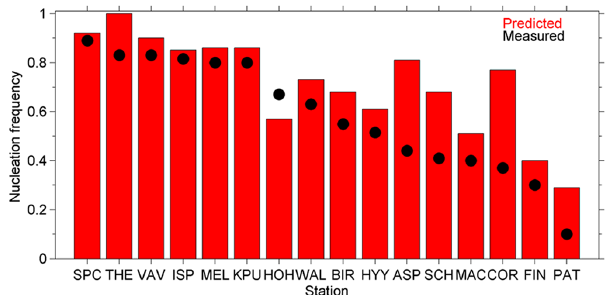
Figure 6. Predicted (red bars) vs. observed (black symbols) nucle- ation frequencies at the 16 measurement stations during 5 June– 8 July 2012.